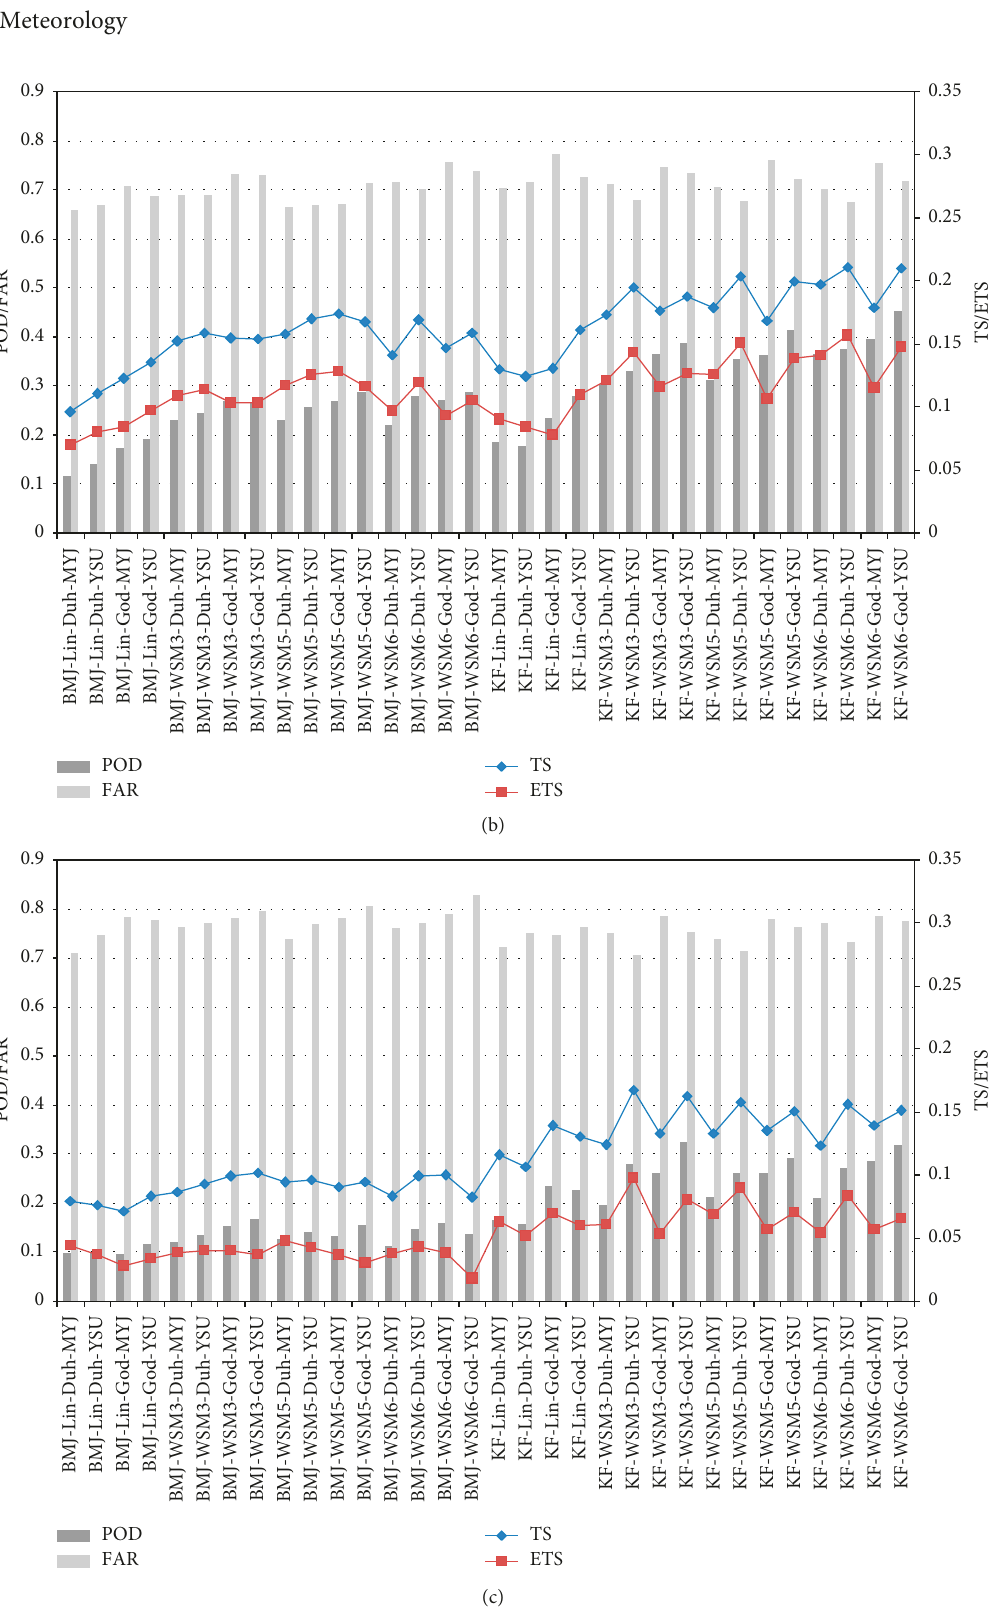
Figure 6: Skill scores calculated for northern Vietnam for daily accumulation thresholds over 50mm for (a) 24h, (b) 48 h, and (c) 72h forecast ranges. The dark grey bar is for POD, light grey bar is for FAR, blue dotted line is for TS, and red dotted line is for ETS. In each chart, the left vertical axis (0–0.9) is for POD and FAR, while the right vertical axis (0–0.35) is for TS and ETS values. The number of samples is 8064 for an individual